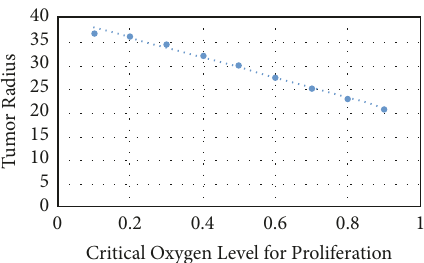
Figure 16: Dependence of tumor radius on critical oxygen concentration 𝑐 𝑐𝑟𝑖𝑡1 for proliferation at time 𝑡 = 20 for the standard set of